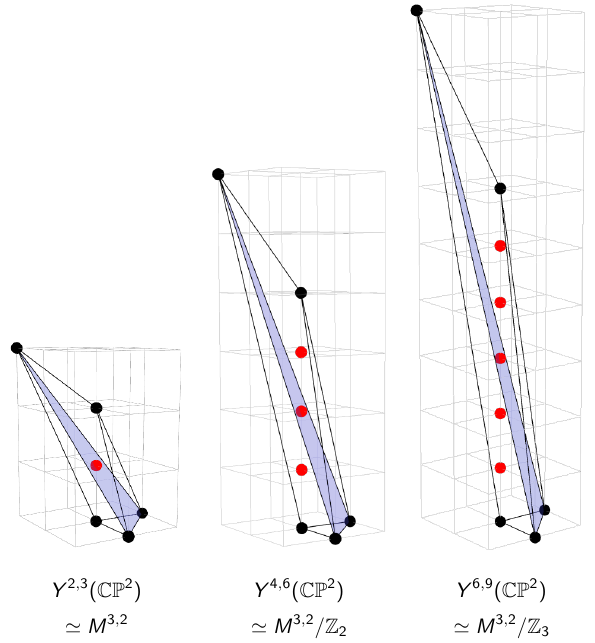
Figure 3 . Y p,k ( CP 2 ) with p = 2 k = 2 m and m ∈ Z + is equivalent to the abelian orbifolds of the 3 form M 3 , 2 / Z m . The corresponding 2 d (0 , 2) theories can be obtained via orbifold reduction [35] of the 4 d N = 1 theory corresponding to dP 0 . The highlighted plane indicates the toric diagram for dP 0